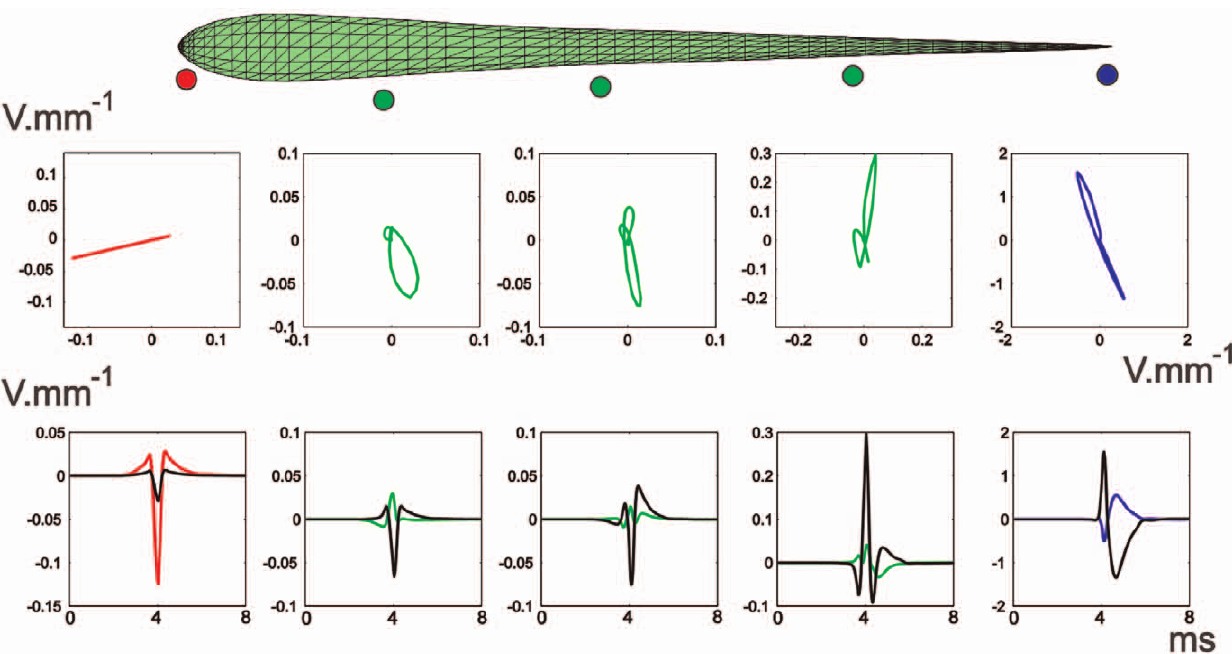
Figure 5. Pericorporal Local Electric Field. Top: The time course of the electric field along the EOD, at different points on a horizontal plane, near the lateral skin of the fish. The colored dots indicate schematically the position in space where the field was calculated. Bottom: LEOD components at the same positions of the electric field. Colored traces correspond to longitudinal values and black traces to transversal values.